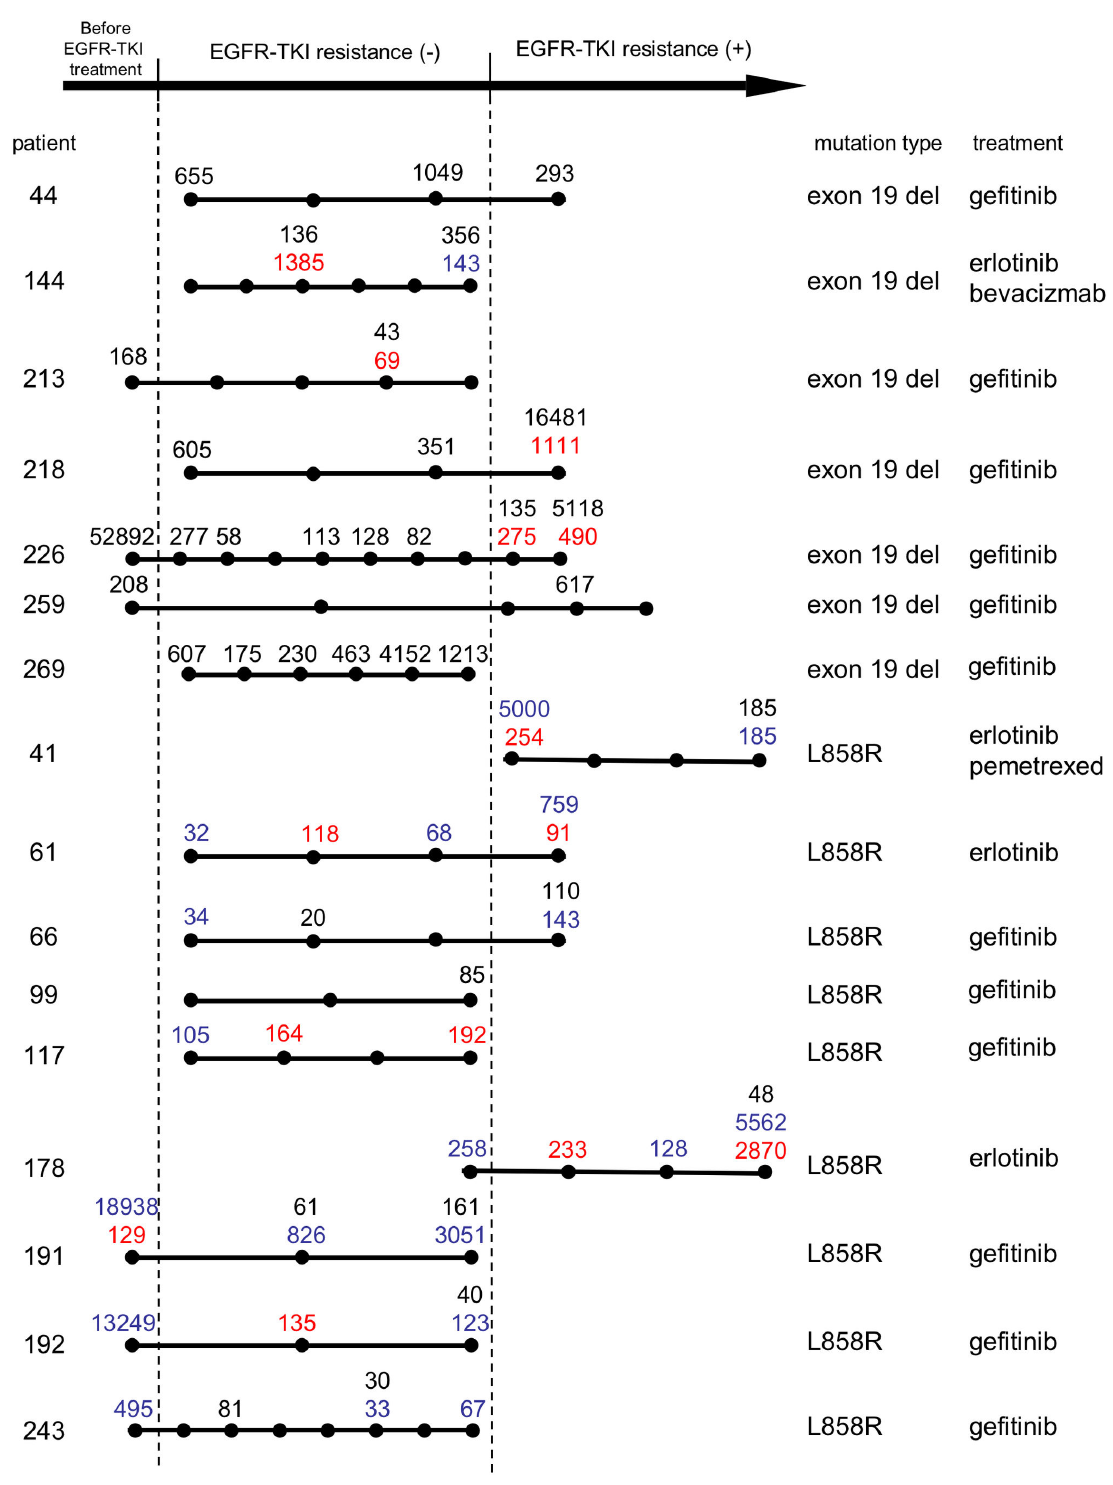
Figure 3. Temporal changes of EGFR mutations in plasma DNA from patients with three or more samples. Each dot represents a time point of sampling. The diagram is not precise representation of time scale, and only the order of dots is valid information. Figures represent EGFR mutations in 10,000 sequence reads: black, exon 19 deletion; blue, L858R; red, T790M. Only figures exceeding the thresholds are shown. “Mutation type” indicates that in the biopsy samples. doi: 10.1371/journal.pone.0081468.g003 PLOS ONE |